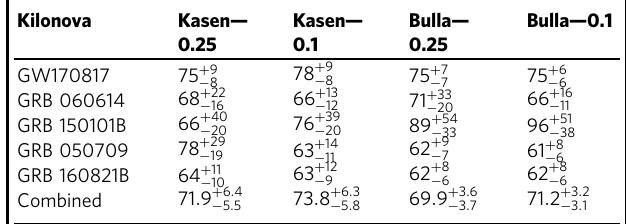
Table 1 Summary of H 0